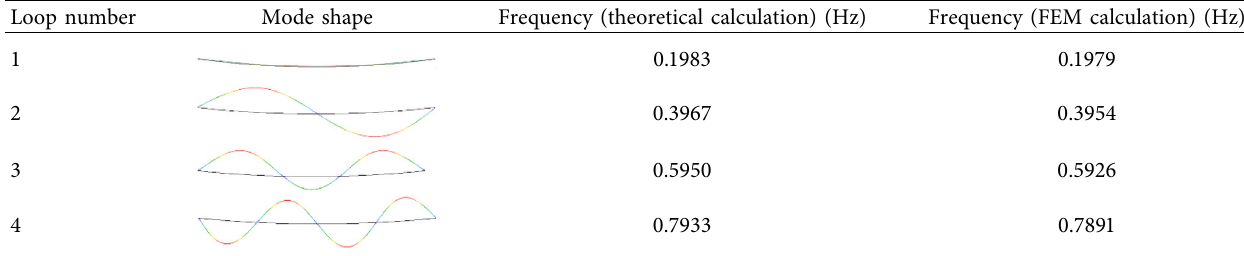
Table 1: In-plane modal analysis results of transmission